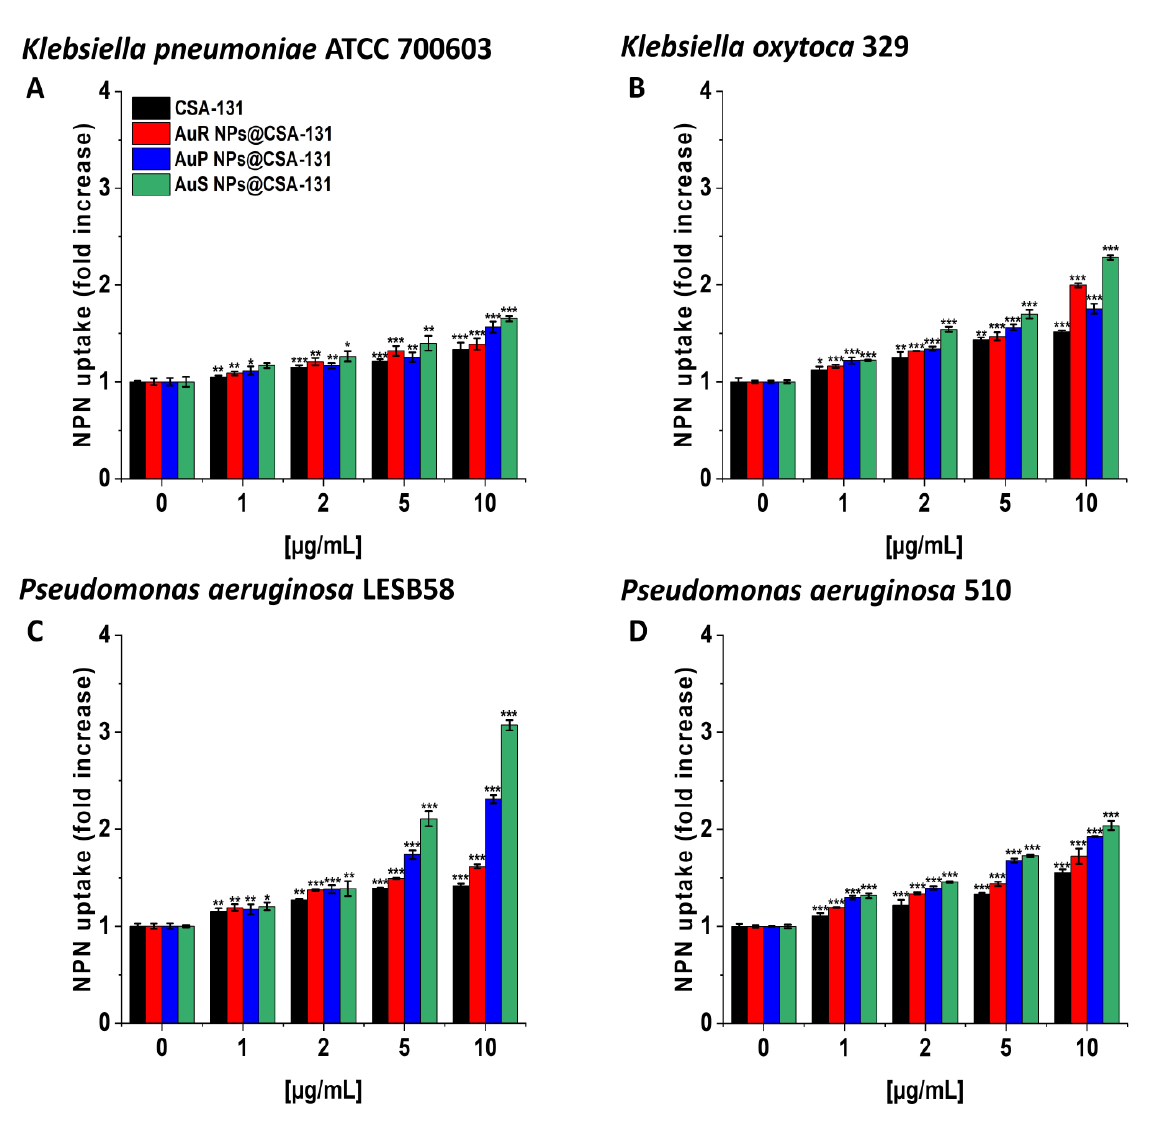
Figure 4. The increase of the outer membrane permeability of Klebsiella pneumoniae ATCC 700603 ( A ), Klebsiella oxytoca 329 ( B ), Pseudomonas aeruginosa LESB58 ( C ), and Pseudomonas aeruginosa 510 ( D ) subjected to the tested nanoparticles. Uptake of NPN by microorganisms upon treatment with AuR NP@CSA-131, AuP NP@CSA-131, AuS NP@CSA-131, and CSA-131 at a concentration of 1–10 µg/mL was investigated using the fluorimetric method. Results show the mean ± SD, n = 3; * indicates statistical significance at p ≤ 0.05, ** ≤ 0.01, and *** ≤ 0.001.